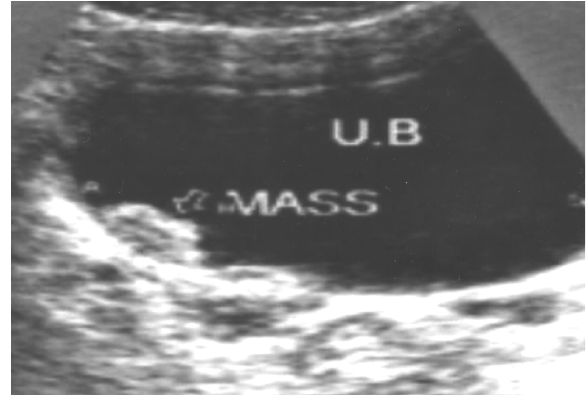
Figure 2 – A tumor 1.8 x 1.4 cm in left posterolateral wall of urinary bladder.